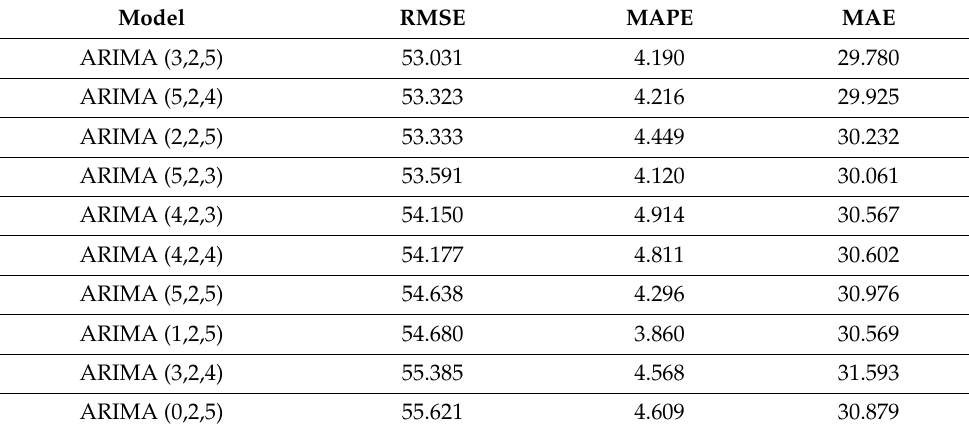
Table 9. Criteria of confirmed cases according to ARIMA.